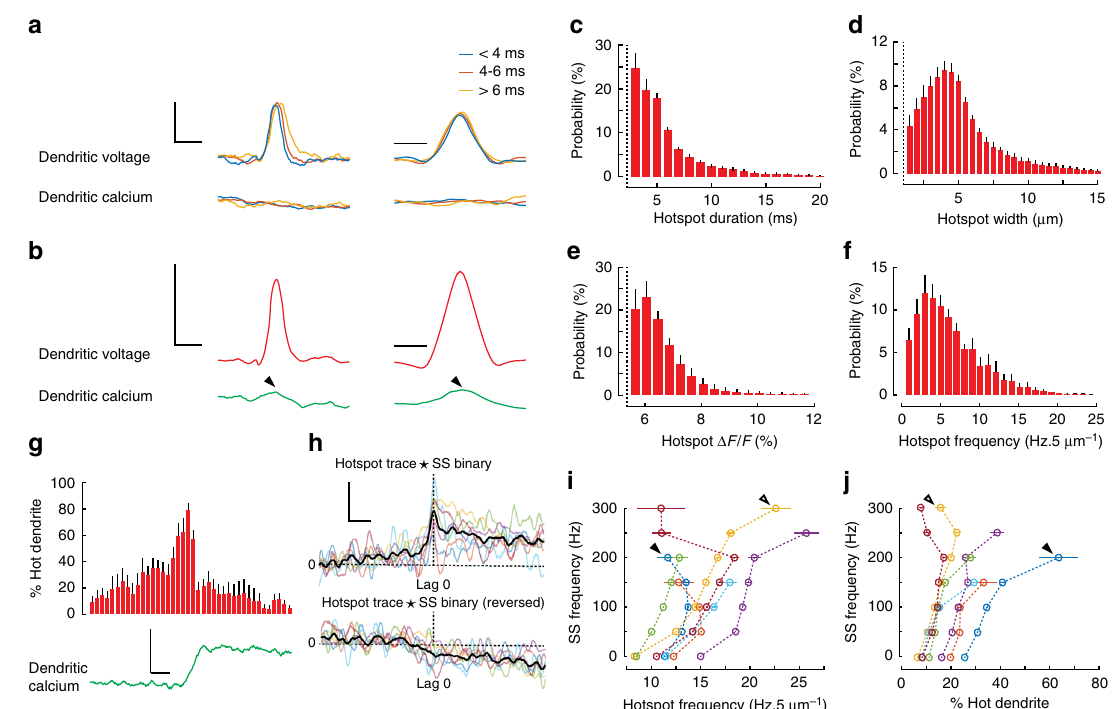
Fig. 6 Rapid and localized subthreshold dendritic voltage hotspots show nonlinear relationships with dendritic calcium and somatic output. a Averaged isolated hotspots (216 in total, single PN) showing pro fi les of voltage (top traces) and calcium (bottom traces) (vertical scale bar 5% Δ F / F , corresponding to about 11 mV) in the temporal dimension (left traces; horizontal scale bar 10 ms) and the spatial dimension (right traces; horizontal scale bar 5 μ m), grouped based on temporal duration of their ROIs. b Averaged isolated hotspots (1534 in total) showing pro fi les of voltage (top traces) and calcium (bottom traces) from all seven PNs (vertical scale bar 5% Δ F / F , corresponding to about 11 mV) in the temporal dimension (left; horizontal scale bar 10 ms) and the spatial dimension (right; horizontal scale bar 5 μ m). Probability distributions for c the duration, d width, e amplitude and f frequency of all detected hotspots from seven PNs. g Average hotspot activity (percent hot dendrite in 5 ms bins) and average dendritic calcium (green trace; vertical scale bar 5% Δ F / F ; horizontal scale bar 20 ms) during 13 DS events from a single PN. h Cross-correlations from all PNs, showing temporal relationship between hotspot traces and SS traces (top coloured traces), and cross-correlations from the same PNs, using reversed hotspot input traces (bottom coloured traces), thick black traces show group averages (vertical scale bar 0.1% Δ CC/CC; horizontal scale bar 20 ms). i Relationships between hotspot frequency (Hz/5 μ m) and SS frequency for seven PNs and j the corresponding relationship between percent hot dendrite and SS frequency, calculated using a 20 ms kernel with 1 ms increments. Bars show mean ±